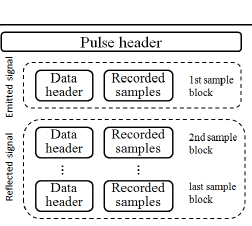
Figure 3. Principle of semi-automatic MTA